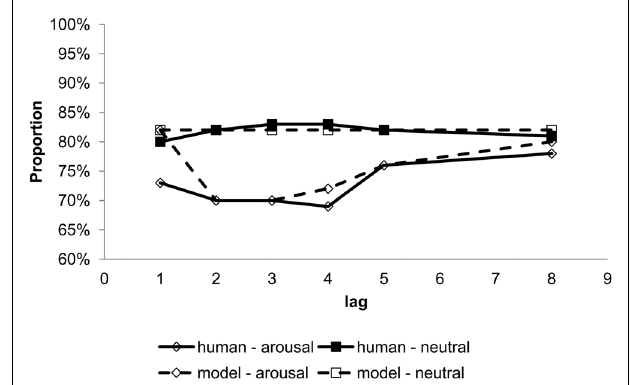
FIGURE 7 |Target report accuracy by serial position comparing human data (Arnell et al., 2007) and model simulation for arousal sexual-related and neutral key-distractors.